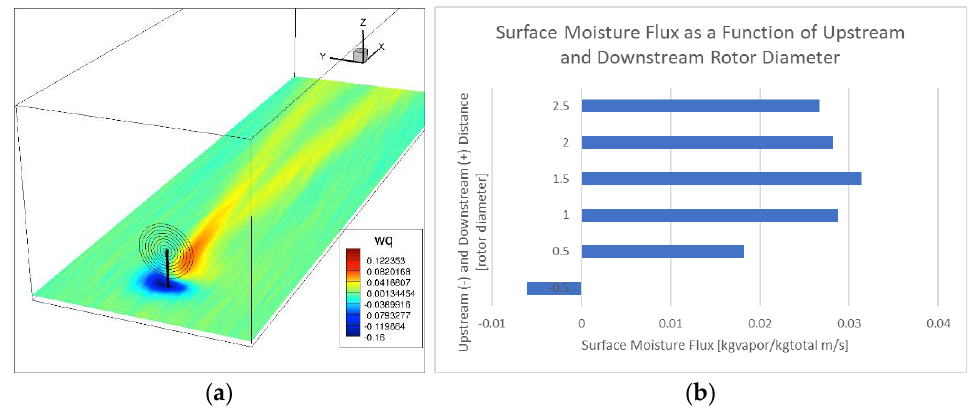
Figure 1. ( a ) Contour plots of LES averaged surface moisture flux in a horizontal plane section (the legend shows surface moisture flux in units of kg water vapor /kg total air m/s; ( b ) observed values of surface moisture flux, as a function of upstream and downstream rotor diameter, obtained by a meteorologically-instrumented uncrewed aircraft in a horizontal plane 3 m above the crop canopy.